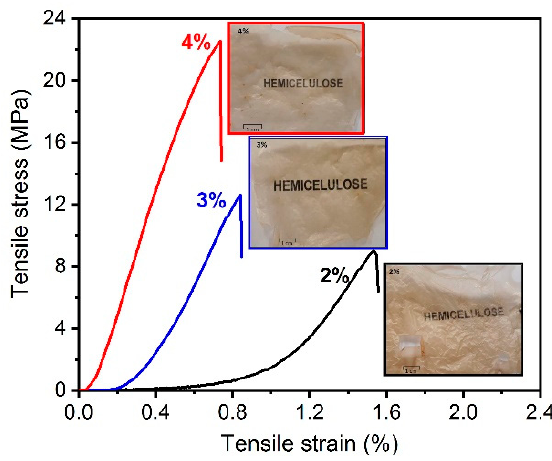
Figure 3. Tensile strain curves of hemicellulose films. Table 2. Tensile results of the hemicellulose films developed.